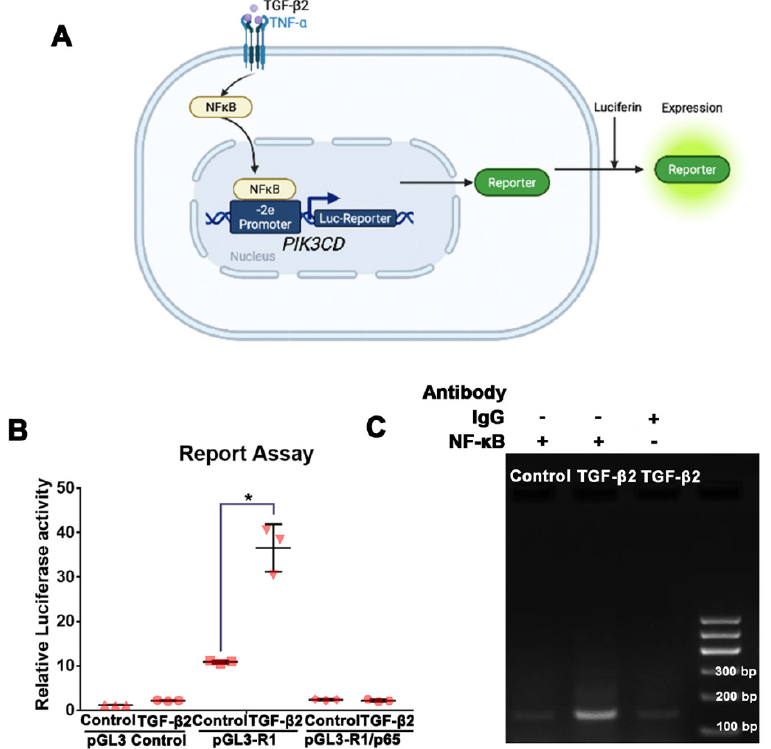
Figure 5. NF κ B/p65 binding to the PIK3CD -2e promoter is required for TGF- β 2-induced expression of p110 δ in ARPE-19 cells. ( A , B ). After cells had attached to a 96-well plate, they were transfected overnight with p-GL3-R1 (or p-GL3 control) or pRL-RK using lipofectamine 3000. Cells were then treated with TGF- β 2 (10 ng/mL) for the next 24 h. Firefly luciferase activity and Renilla luciferase activity were read in a TD-20/20 luminometer. Data were calculated as firefly luciferase activity/Re- nilla luciferase activity. The mean ± SD of 3 independent experiments is shown. Data were analyzed using one-way ANOVA followed by the Tukey HSD post hoc test. * Denotes p < 0.05. ( C ). NF κ B/p65 binding to the PIK3CD -2e promoter determined by a ChIP assay. DNA from ChIP was subjected to PCR and gel analysis. Non-immune IgG served as a negative control. 3.6. Depletion of PI3K δ Prevents TGF- β 2-Induced Migration of RPE Cells We next used a scratch-wound assay to examine if PI3K δ depletion could prevent TGF- β 2-induced migration of ARPE-19 cells because this cellular event is critical for the formation of epiretinal membranes, whose contraction causes retinal detachment [44]. As shown in Figure 6A,B, TGF- β 2 promoted migration of ARPE-19 cells with lacZ- sgRNA/SpCas9 at 16 h, but depletion of p110 δ with PK2-sgRNA/SpCas9 significantly at- tenuated TGF- β 2-induced migration of these cells at this time point, demonstrating that inactivation of PI3K δ could prevent PVR pathogenesis.